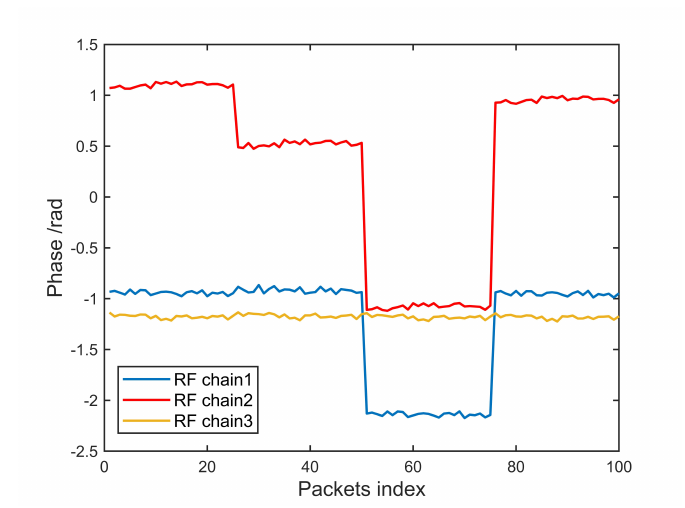
Figure 2. Phase offsets of the 15th